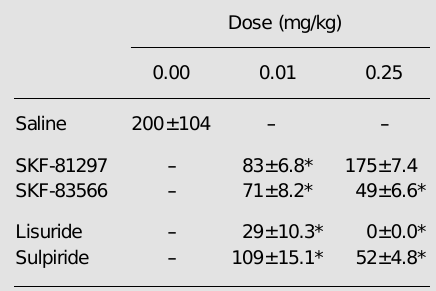
Table 2. Effects of stimulation and blockade of dopamine receptors on time spent in general grooming behavior by pregnant